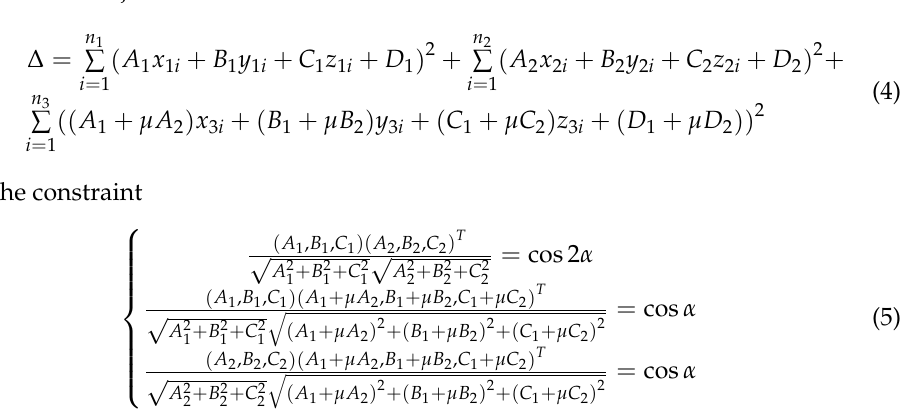
Figure 8. Three light planes in space.